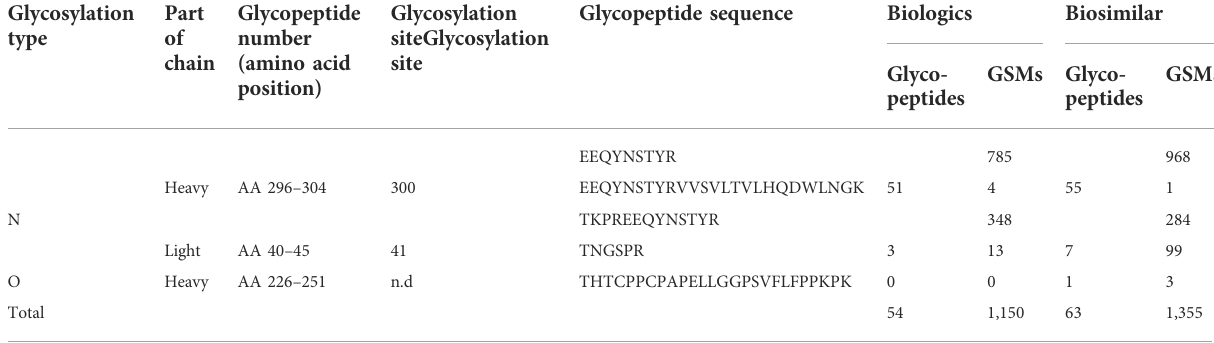
TABLE 1 Identi fi ed N-glycopeptides and glycosylation sites from tandem spectra of In fl